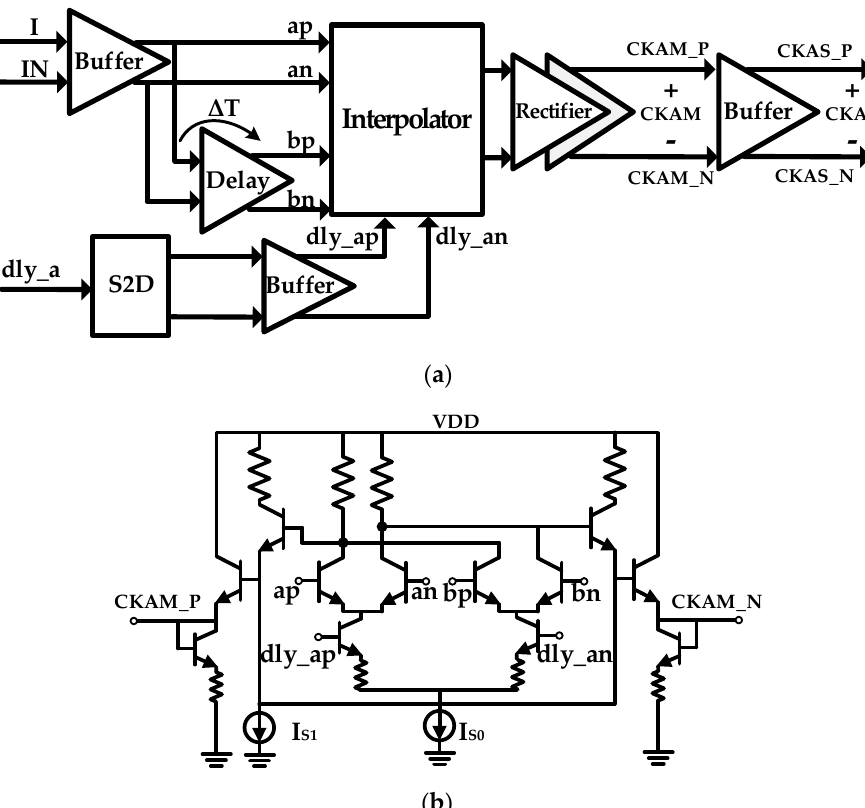
7 of 16 Figure 5. Simulated common-mode voltage fall with different size of Q4 (with 0.15 μ m emitter width). 3.2. Interpolator-Based Phase Regulator The sampling timing is under control of four-phase differential clocks generated by the phase regulator, as shown in Figure 1. For a 6-bit resolution with an input frequency of 10 GHz, the standard deviation of the timing mismatch is required to be less than 0.2 ps, which corresponds to 0.36 degree [20–22]. An interpolator-based phase regulator is employed in the clock path to calibrate the timing mismatch in the analog domain, thus large area cost and complicated algorithm in digital calibration are avoided. Taking I/IN as an example, Figure 6a shows the schematic of the phase adjusting and Figure 6b demonstrates the circuit implementation of interpolator. An input pair of the interpolator ( ap/an ) is the buffered I/IN , another input pair ( bp/bn ) is the delayed ap/an through a CML buffer. The output CKAM is utilized to drive the track-hold switch in master stage directly, and in slave stage after a CML buffer, matching the delay between the track-hold switches of the two stages. The two pairs of inputs are interpolated by the control voltage dly_ap/an , generated by dly_a through an S2D converter. The output of the interpolator y(t) can be expressed as the function of input ap/an and bp/bn : y(t) = α ∙ A ∙ sin(ωt) + β ∙ B ∙ sin(ωt + θ) = (cid:3493)(𝛼𝐴) (cid:2870) + 2𝛼𝛽𝐴𝐵 ∙ 𝑐𝑜𝑠𝜃 + (𝛽𝐵) (cid:2870) ∙ sin (cid:3428)𝜔𝑡 + 𝑎𝑟𝑡𝑎𝑛 𝛽𝐵 ∙ 𝑠𝑖𝑛𝜃 𝛼𝐴 + 𝛽𝐵 ∙ 𝑐𝑜𝑠𝜃(cid:3432) (4) where 𝐴 ∙ 𝑠𝑖𝑛 (𝜔𝑡) indicates the input ap/an , 𝐵 ∙ 𝑠𝑖𝑛 (𝜔𝑡 + 𝜃) is another input bp/bn , 𝜃 denotes the phase difference between ap/an and bp/bn generated by the CML buffer, and 𝛼 and 𝛽 are the corresponding interpolation weights controlled by dly_ap/an . It can be seen that output amplitude of